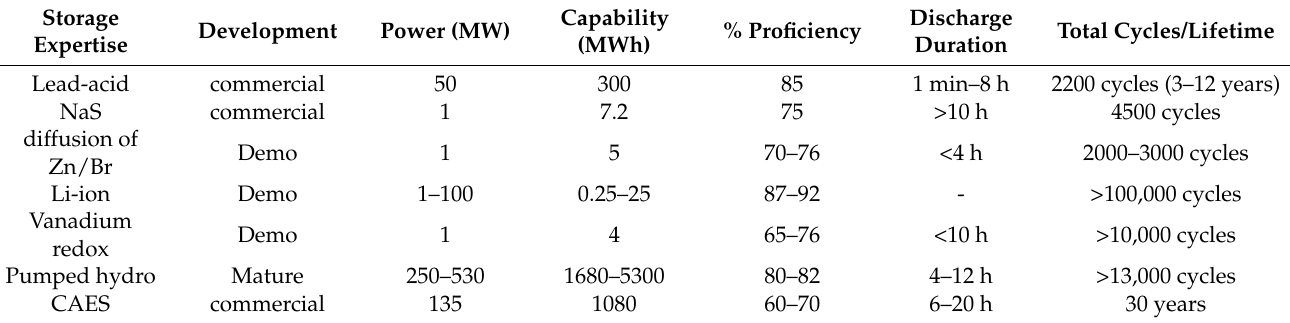
Table 1. Energy Storage Technology Comparisons